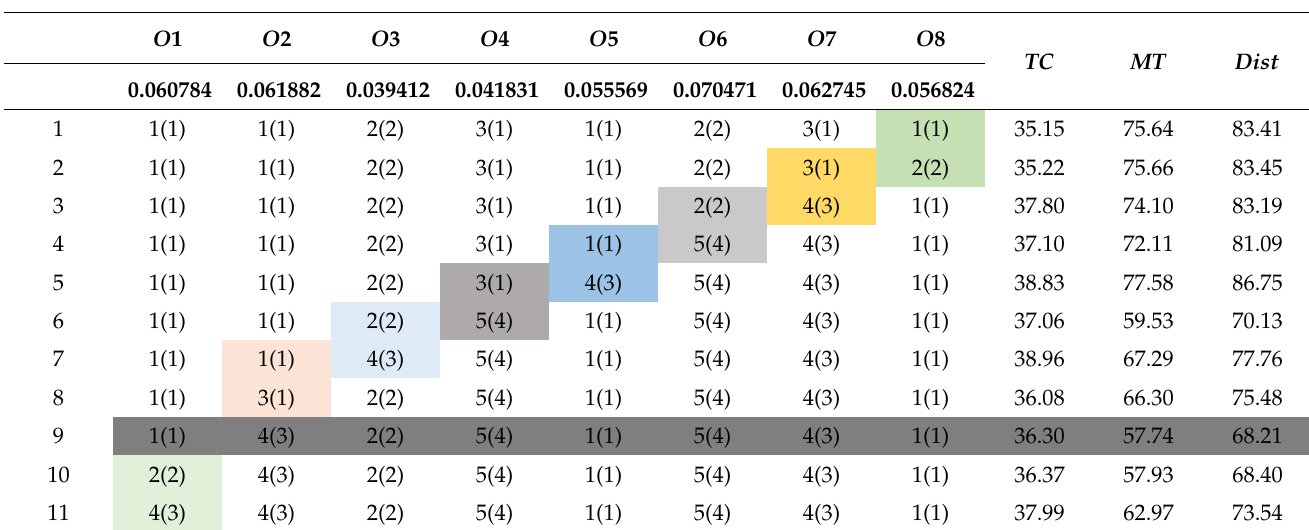
Table 2. Result of univariate search method for the existing problem.